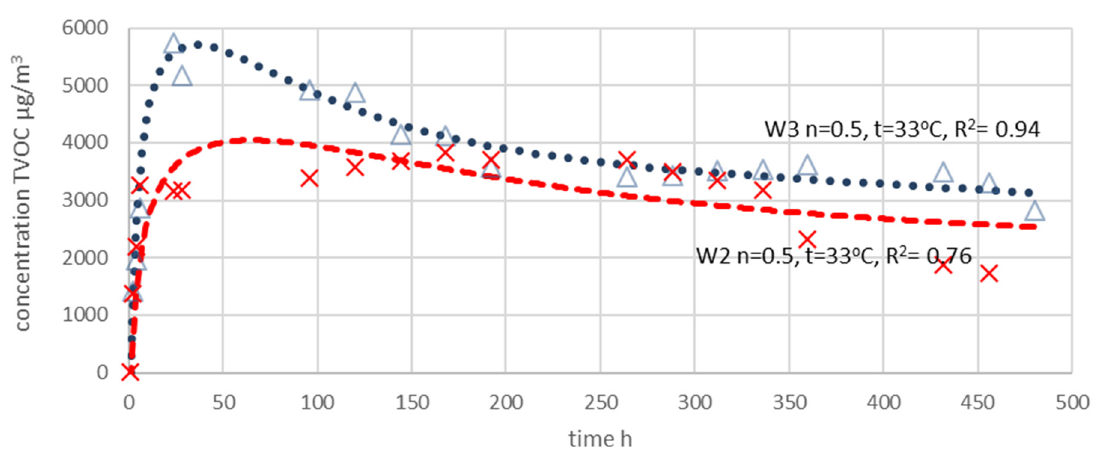
Figure 13. The TVOC emission profiles from W3 and W2 floor systems (tested for 480 h) for the air change rates n = 0.5 h − 1 at 33 °C (and RH=80% for both) in the emission test chamber. (W3 sample is a floor system made of: polyurethane solvent primer, polymer–cement waterproofing (2), epoxy adhesive; W2 is made of: epoxy primer, polymer–cement waterproofing (1) andepoxy adhesive (see Table 3); significant VOCs compounds for these products are provided in Table 1).